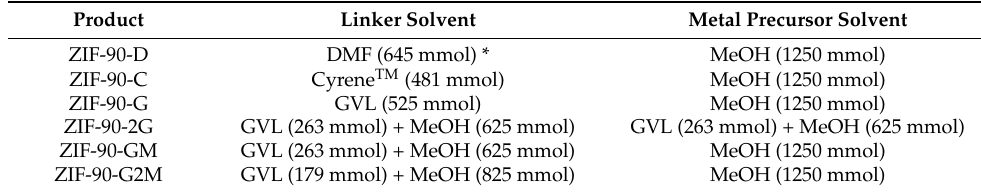
Table 1. Solvent composition for the synthesised zeolitic imidazolate frameworks (ZIF)-90 samples.